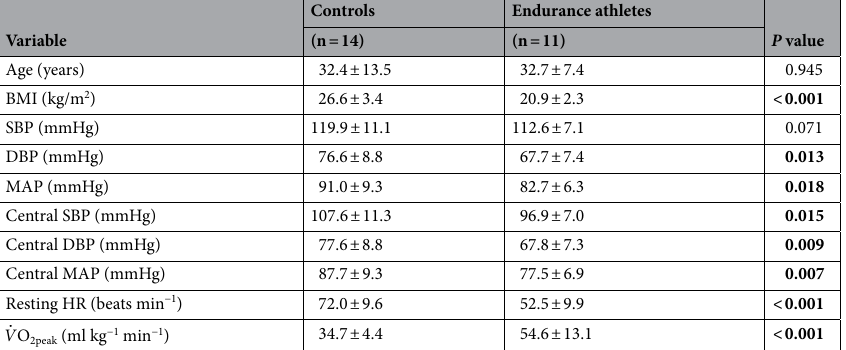
Table 4. Characteristics of endurance athletes and controls in females. Data are expressed as mean ± standard deviation from two-tailed independent samples t -tests or Mann–Whitney U-tests, with P -values below 0.05 bolded. Variances were equal between groups for all variables except for age. BMI, body mass index; SBP, systolic blood pressure; DBP, diastolic blood pressure; HR, resting heart rate; (cardiorespiratory)